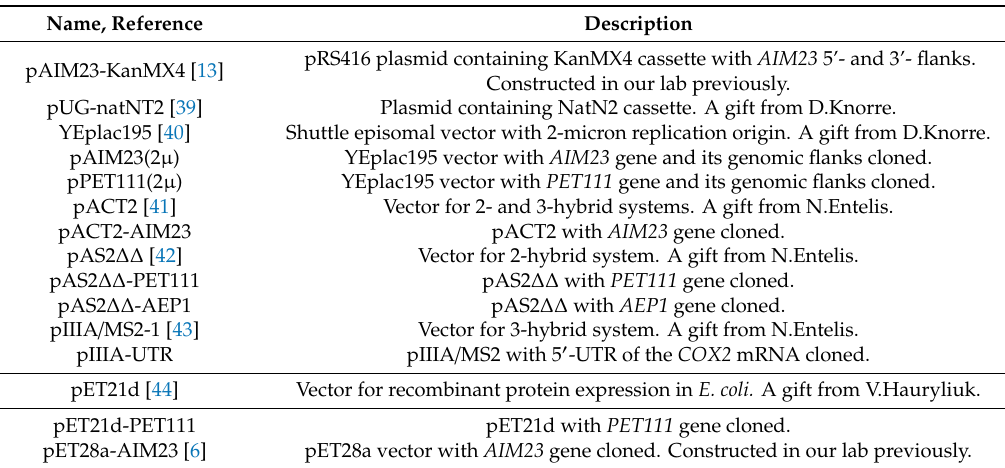
Table 1. Plasmids used in the